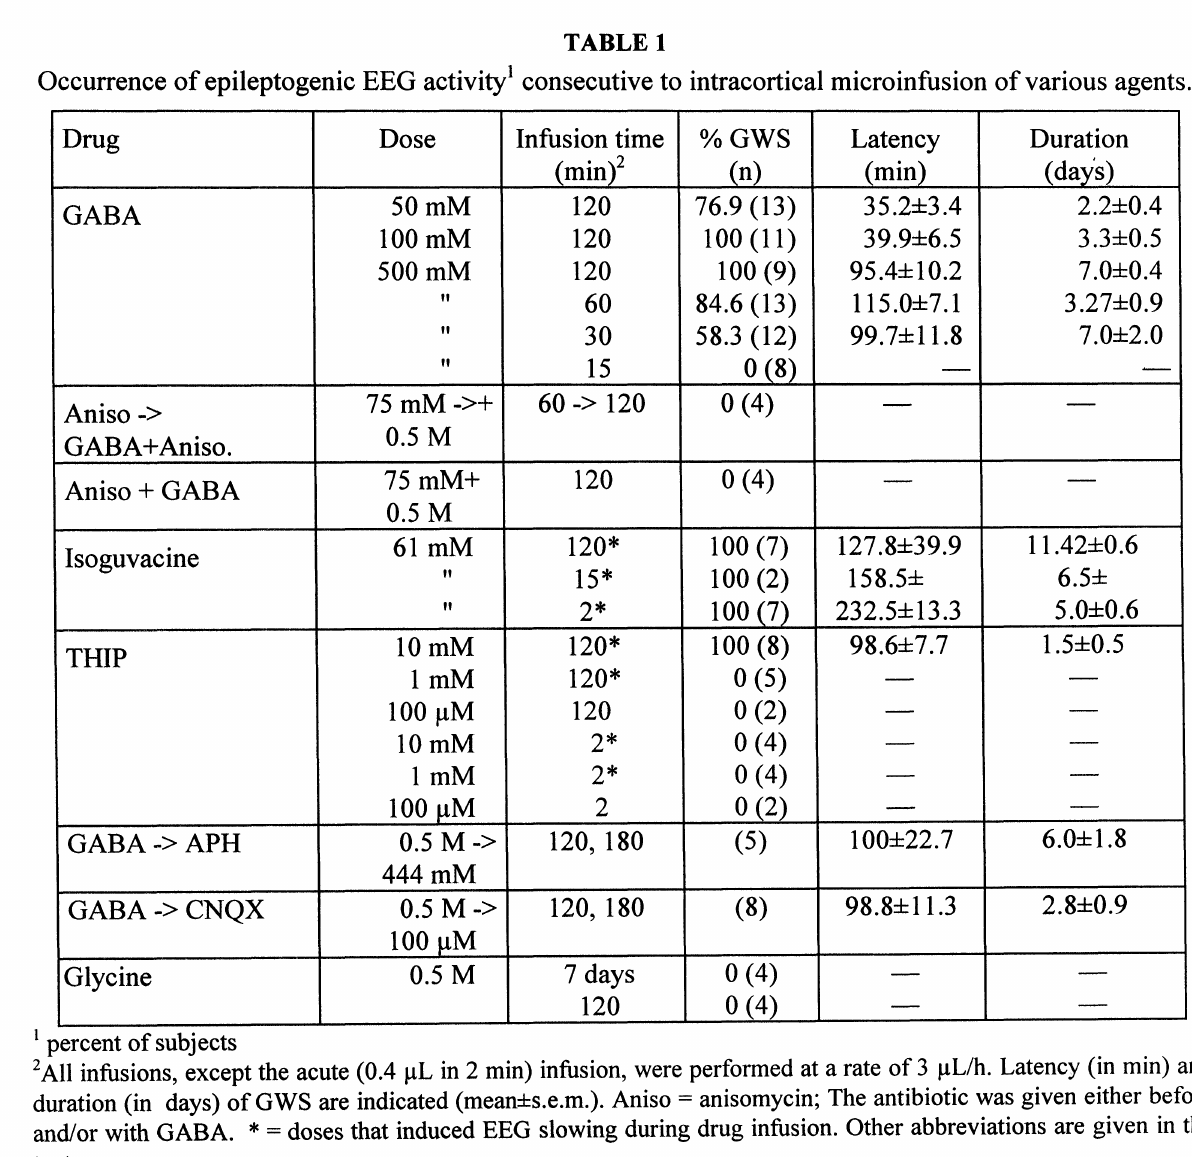
of epileptogenic EEG activity consecutive to intracortical microinfusion of various Occurrence